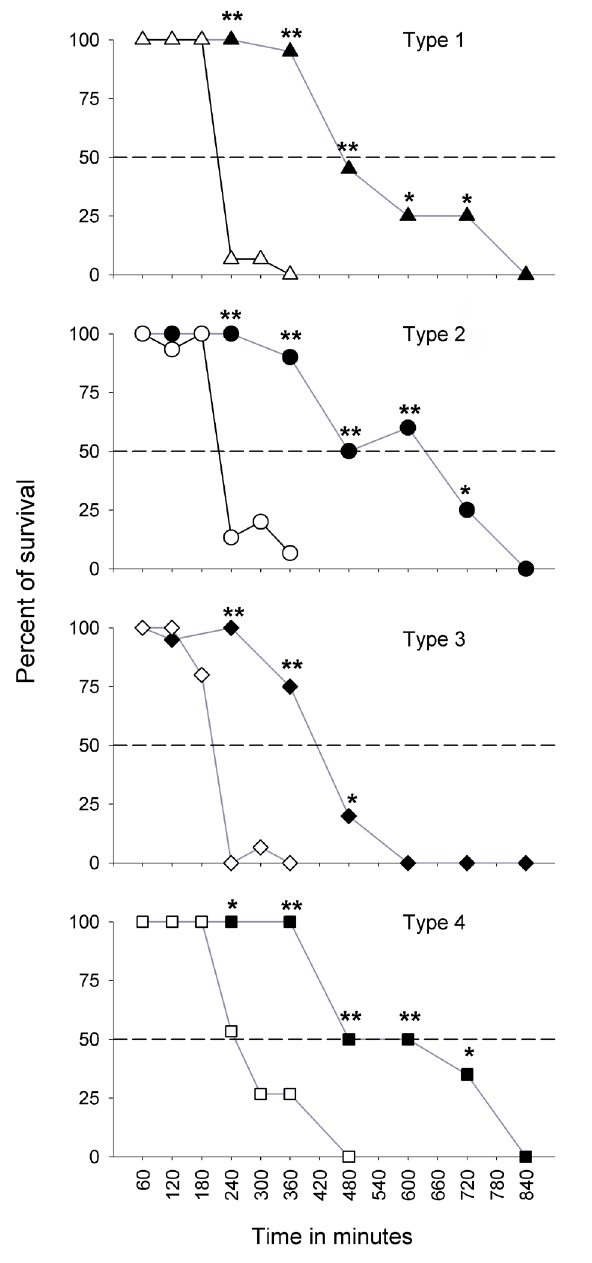
Figure 7. Thermal air-exposure tolerance of Clibanarius erythropus at 35°C (full symbols) and 39°C (open symbols) for each shell type (Type 1 to Type 4). The symbols ** and * indicate higher survivorship at 35°C than at 39°C at a significance level of p < 0.01 and p < 0.05, respectively. Figure 8. Regression lines indicating the thermal air exposure tolerance of the different hermit crab species showing air-exposure behavior. Solid, dashed and dotted lines correspond to Clibanarius erythropus , Cl. albidigitus and Calcinus obscurus , respectively; triangle, circle, diamond and square symbols refer to shell Types 1, 2, 3 and 4, respectively; grey line with full symbols and black lines with open symbols results at 35°C and 39°C, respectively. Data for C. albidigitus and C. obscurus are from Bertness